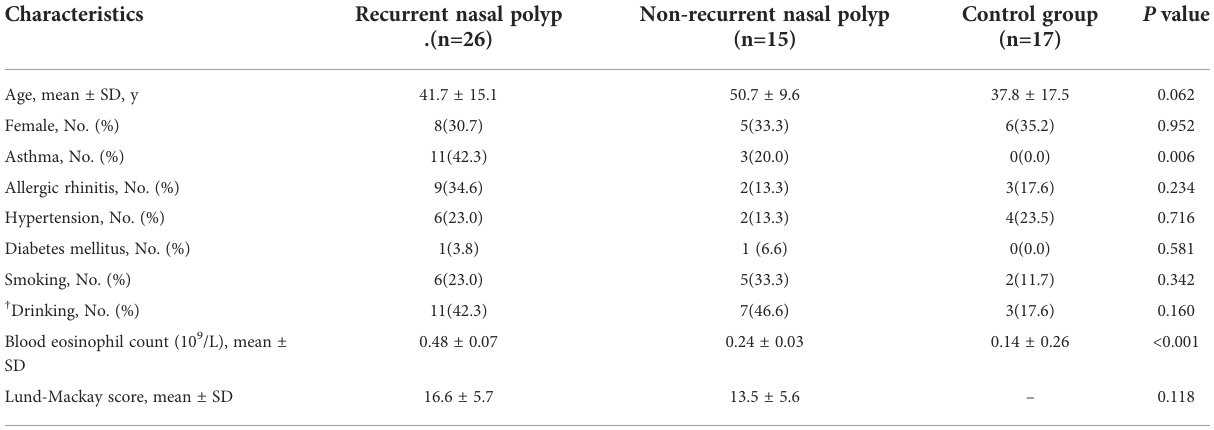
TABLE 1 Characteristics of subjects enrolled in this study.